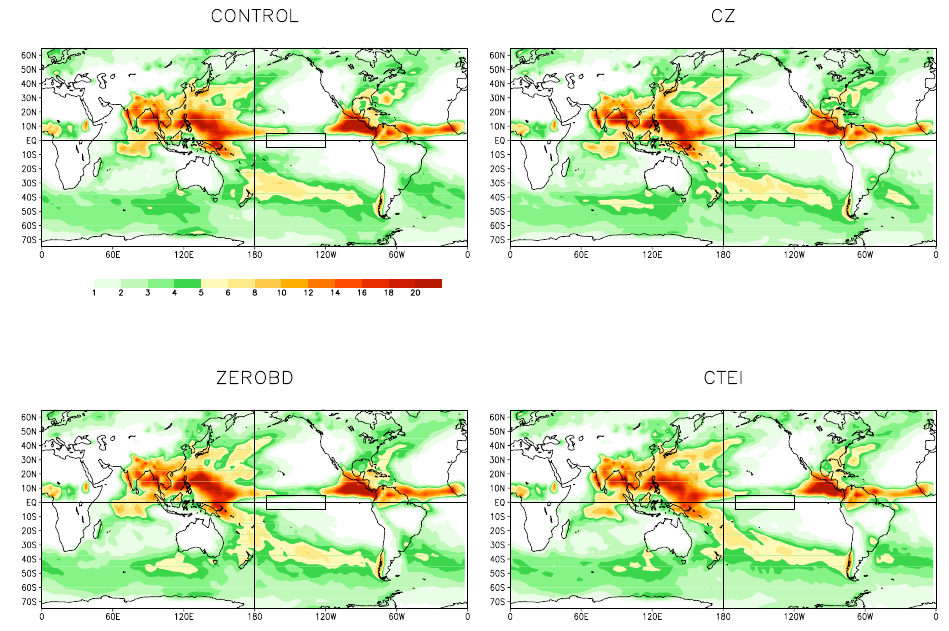
Fig. 16. The July 2008 mean precipitation rate (mm/day) in the four experiments.